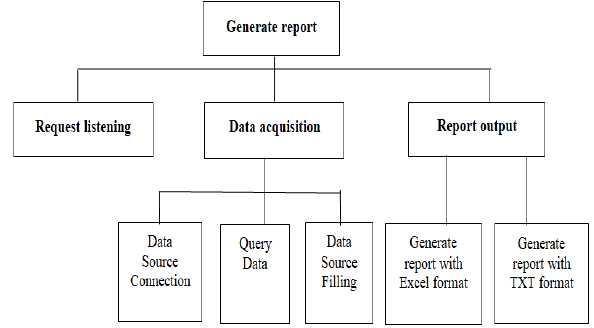
Figure 8. The report outputting module process tree